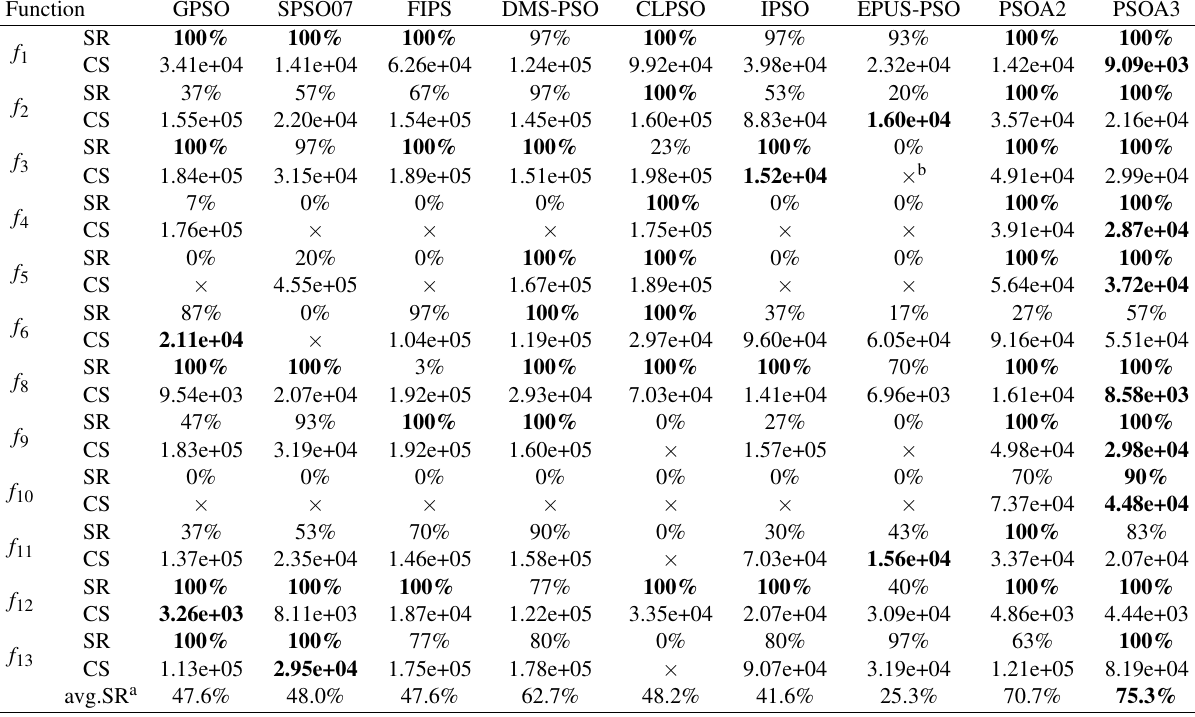
Table 8: t -test results between PSOA3 and GPSO, SPSO07, FIPS, DMS-PSO, CLPSO, IPSO and EPUS-PSO PSOA3 Versus GPSO SPSO07 FIPS DMS-PSO CLPSO IPSO EPUS-PSO Total ≈